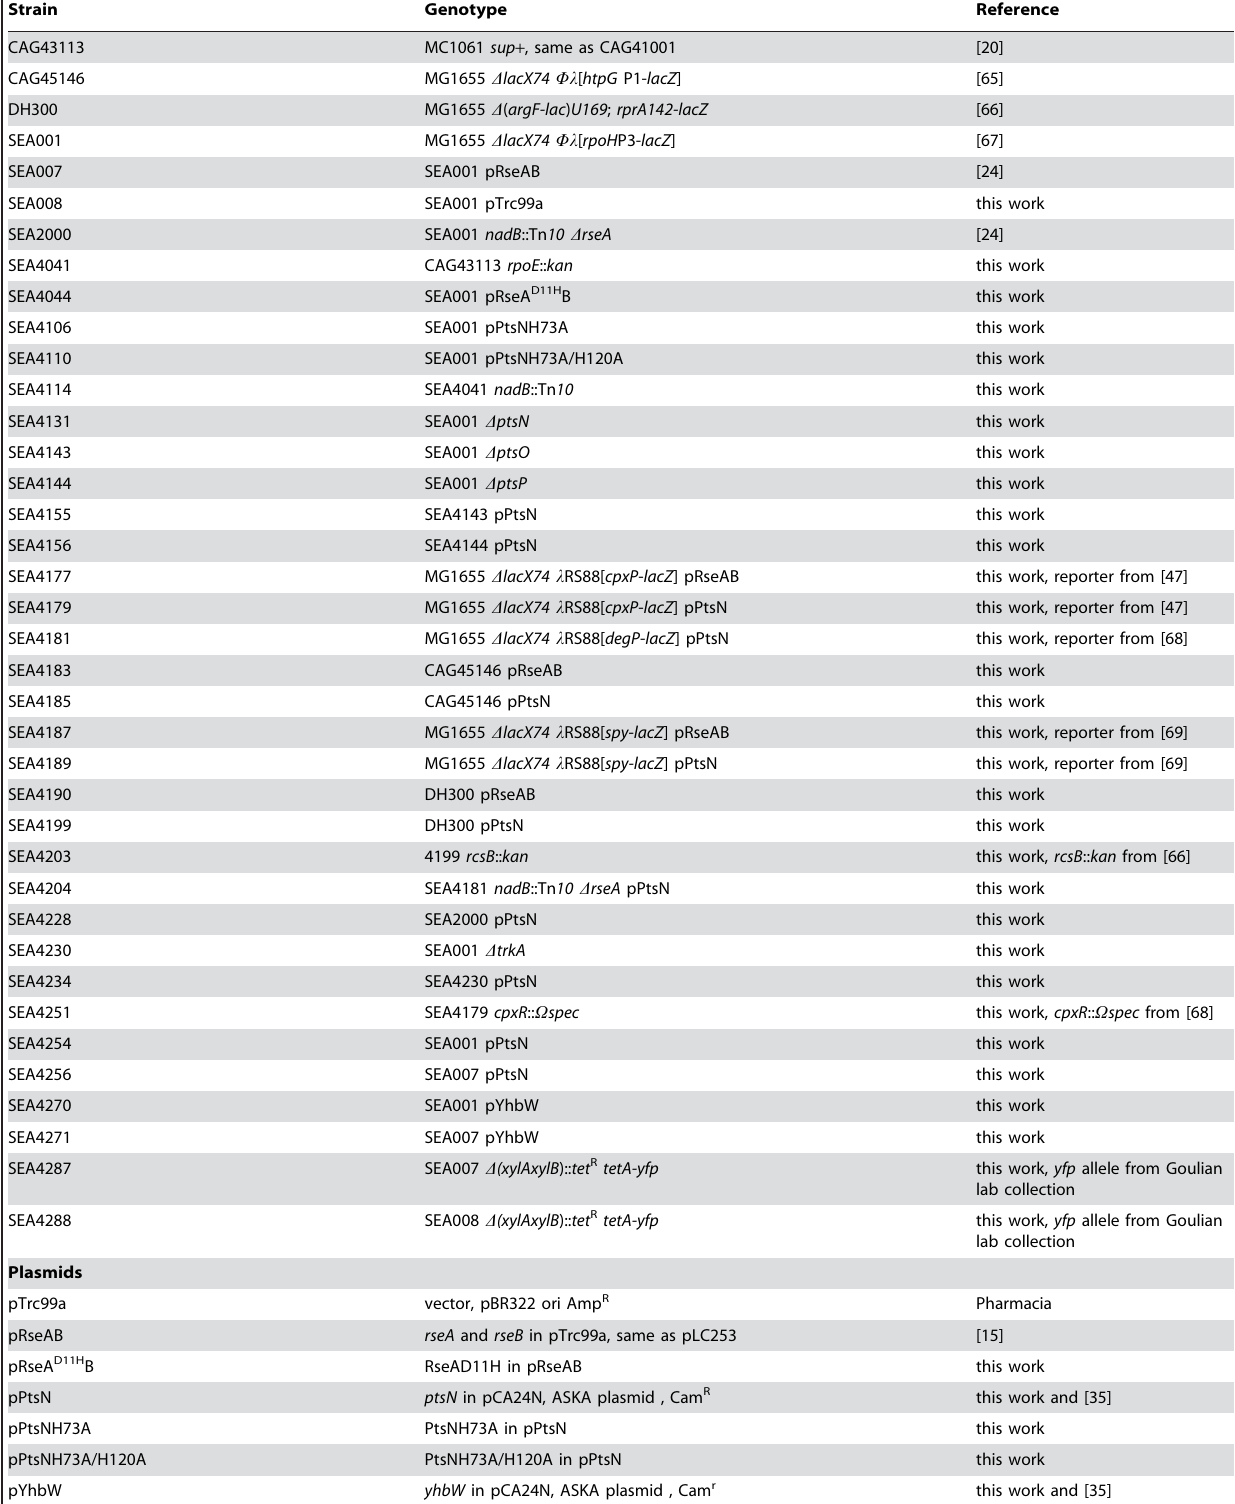
Table 3. Strains and